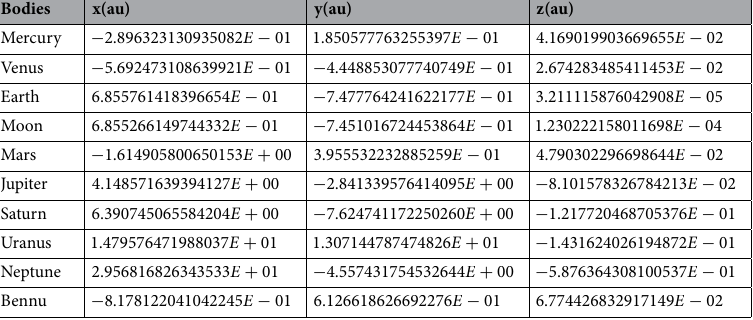
Table 1. Input values for the coordinates of each body as of August 5, 2021. Data taken from JPL NASA.